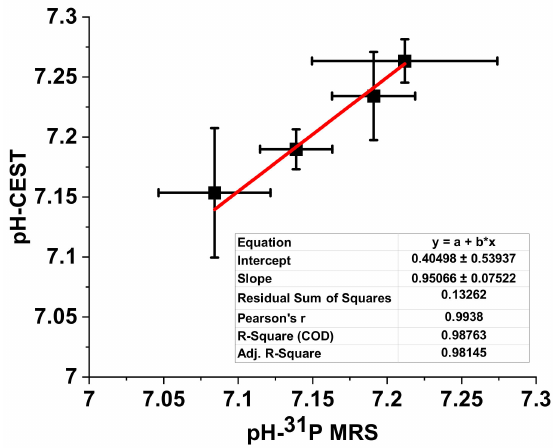
Figure 7. The correlation of pH measurements using 31 P MRS and CEST methods. The relationship between pH values measured by these two methods is almost linear. The di ff erence may be attributed to di ff erences in the size of the area